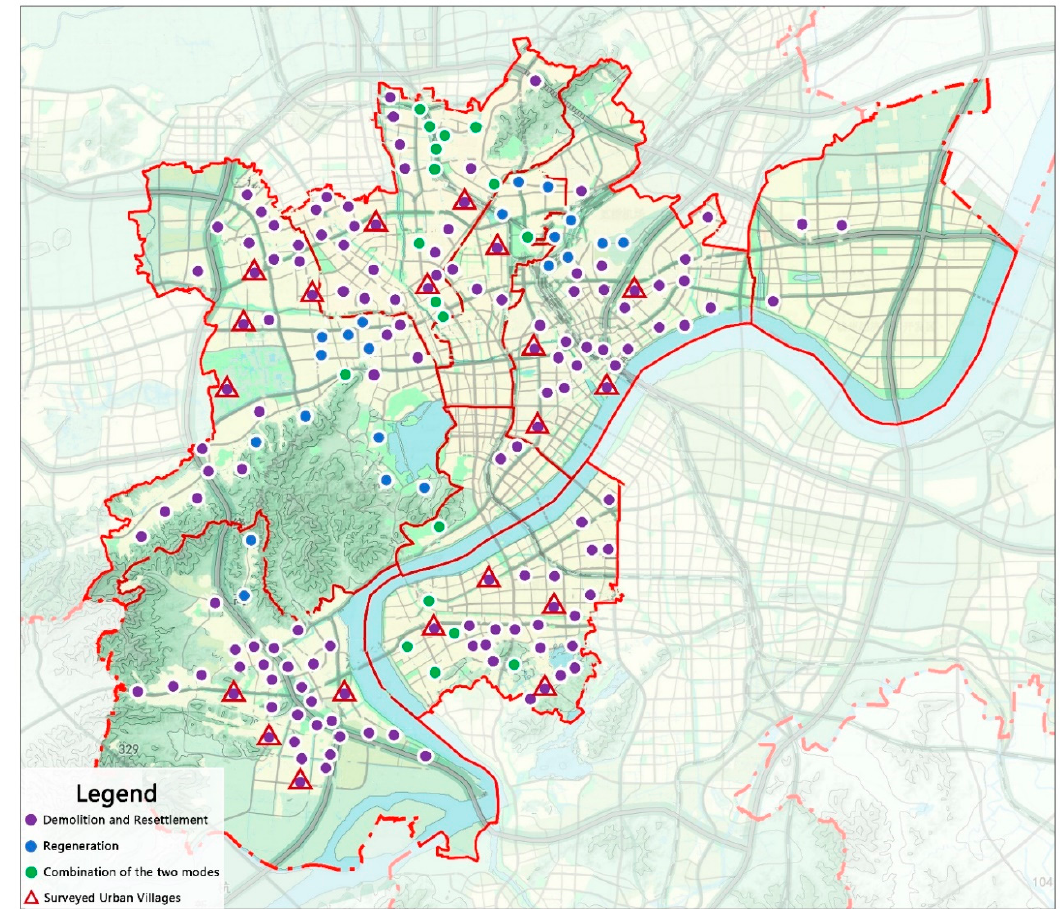
Figure 1. Distribution of 178 Urban Villages to be Redeveloped in Hangzhou, China.